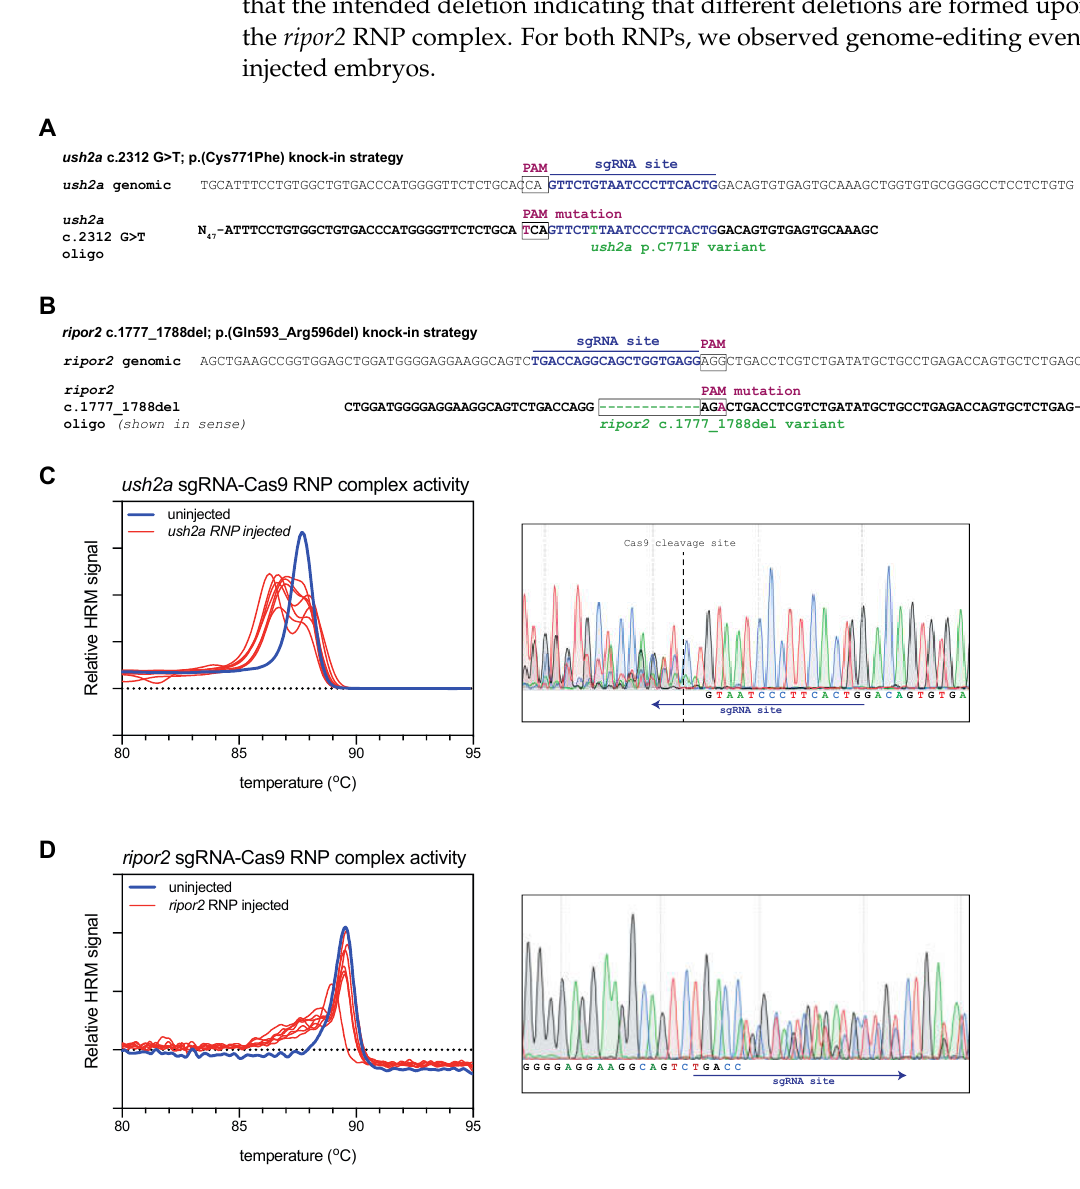
Figure 1. Study design and validation of sgRNA-Cas9 ribonucleoprotein complex efficiency. ( A ) Graphic representation of the target region in ush2a exon 13. The sgRNA (targeting the complementary strand) and protospacer-adjacent motif (PAM) are indicated and allow for Cas9 cleavage in close proximity of position c.2312. The asymmetric antisense template for homology directed repair contains the c.2312G>T variant and a silent PAM-site change. ( B ) Graphic representation of the target region in ripor2 exon 14. The sgRNA is designed to direct Cas9 to cleave within the nucleotide sequence that we aimed to delete. The asymmetric antisense template for homology directed repair, containing the 12-nucleotide deletion and a silent PAM-site change, is shown in sense orientation. ( C ) High resolution melting (HRM) analysis profiles of individual embryos injected with the ush2a sgRNA-Cas9 ribonucleoprotein (RNP) complex. A representative example of the Sanger sequencing traces from a single embryo is shown on the right. The typical overlapping peaks occur around the indicated Cas9 cleavage site. ( D ) HRM analysis profiles of individual ripor2 sgRNA-Cas9 ribonucleoprotein (RNP) complex injected embryos. The typical overlapping peaks in the sanger sequencing traces, shown on the right, are indicative of sgRNA-Cas9 RNP activity.